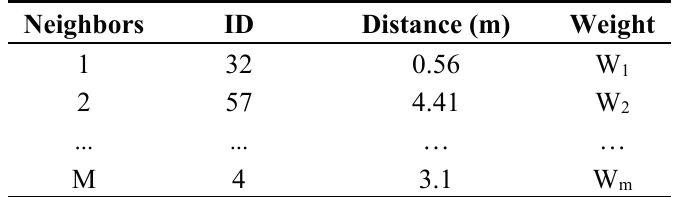
Table 2. Nodes information from network topology in every